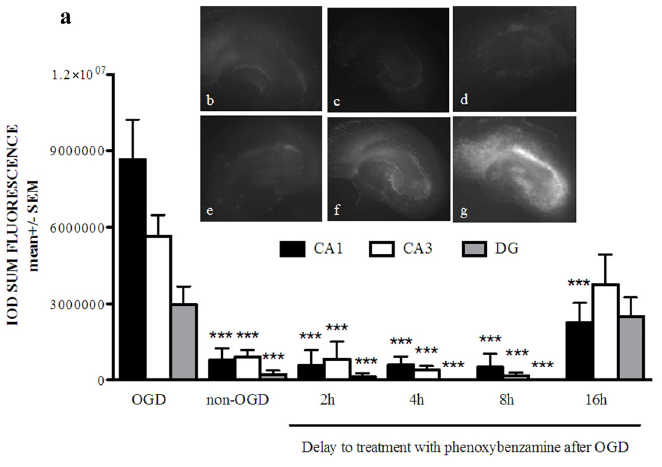
Figure 2. ( a ) Phenoxybenzamine (PBZ), delivered up to 16 h post injury, provides significant neuroprotection from oxygen glucose deprivation in rat hippocampal slice cultures. Rat hippocampal slice cultures were exposed to 60 min of OGD. At various time points after OGD, 100 µM PBZ was added to cultures. 21 h after OGD the slices were stained with propidium iodide and then visualized at 24 h. PBZ treatment at 100 µM significantly reduced neuronal death in the CA1, CA3, and DG region of the hippocampus when delivered at 2, 4, and 8 h post-OGD. Delivery of 100 µM PBZ at 16 h post-OGD significantly reduced neuronal death from OGD in the CA1 region of the hippocampus but did not reduce cell death in the CA3 or DG. *** p < 0.001, n = a minimum of seven slices; ( b ) non-OGD control; ( c ) OGD + phenoxybenzamine treated at 2 h post-OGD; treated at 8 h post-OGD; ( f ) OGD + phenoxybenzamine treated at 16 h